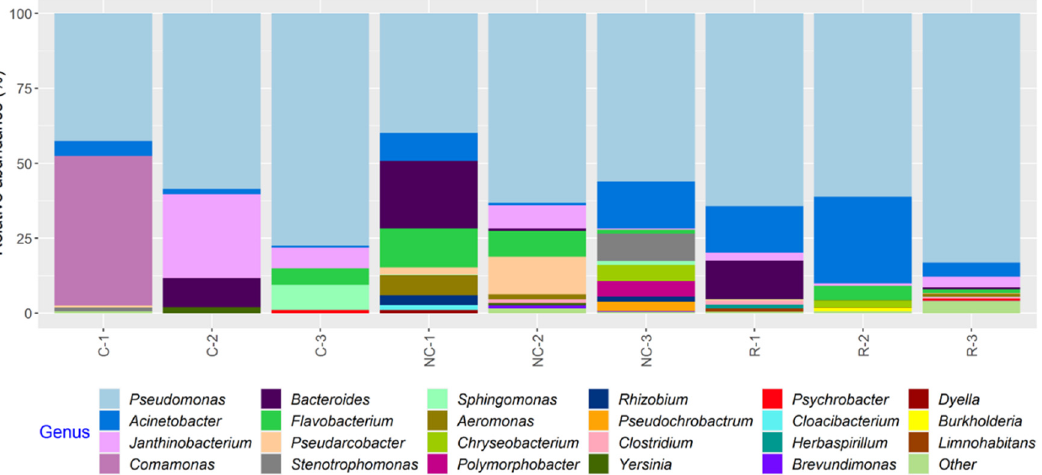
Figure 6. Relative abundance of bacterial genera in samples collected from equipment surfaces determined by 16S rRNA gene amplicon sequence analysis. The samples were collected on three days from the contact (C), non-contact (NC), and roller (R) surfaces of a conveyor belt in a beef processing facility. Genera with a relative abundance <1% in any of the samples were classified as “Other”.